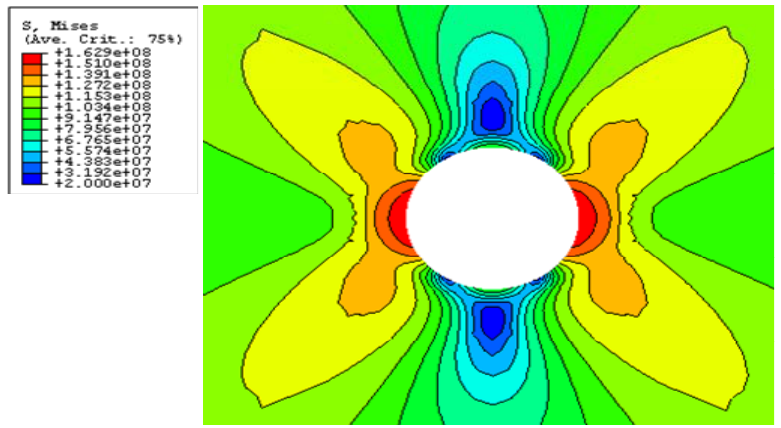
Figure 17. The von-Mises stress distribution around a circular shape pore